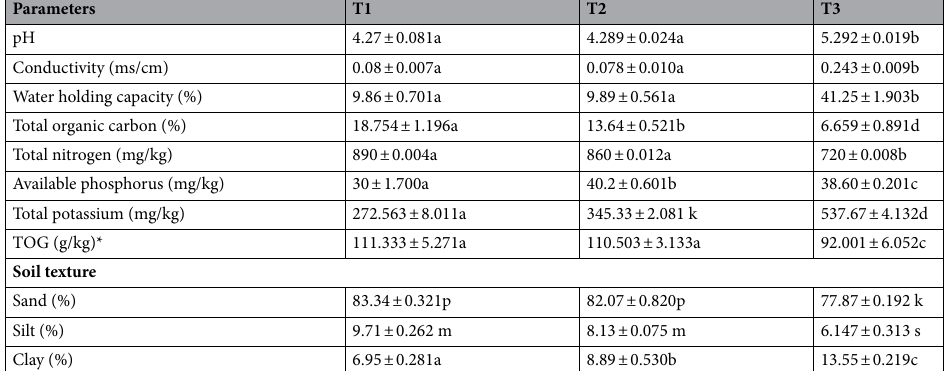
Table 1. Showing the changes in physico-chemicals and total oil and grease profiles in contaminated soil at the beginning and after 60 days of introduction of Cyperus brevifolius. Mean value ± SD, n = 3; the different letters within the same row represent the significant differences of the values (ANOVA, LSD test, P ≤ 0.05 ).T1- Crude oil contaminated soil (Initial); T2- Crude oil contaminated soil without Cyperus brevifolius ; T3- Crude oil contaminated soil + Cyperus brevifolius. *Total oil and grease